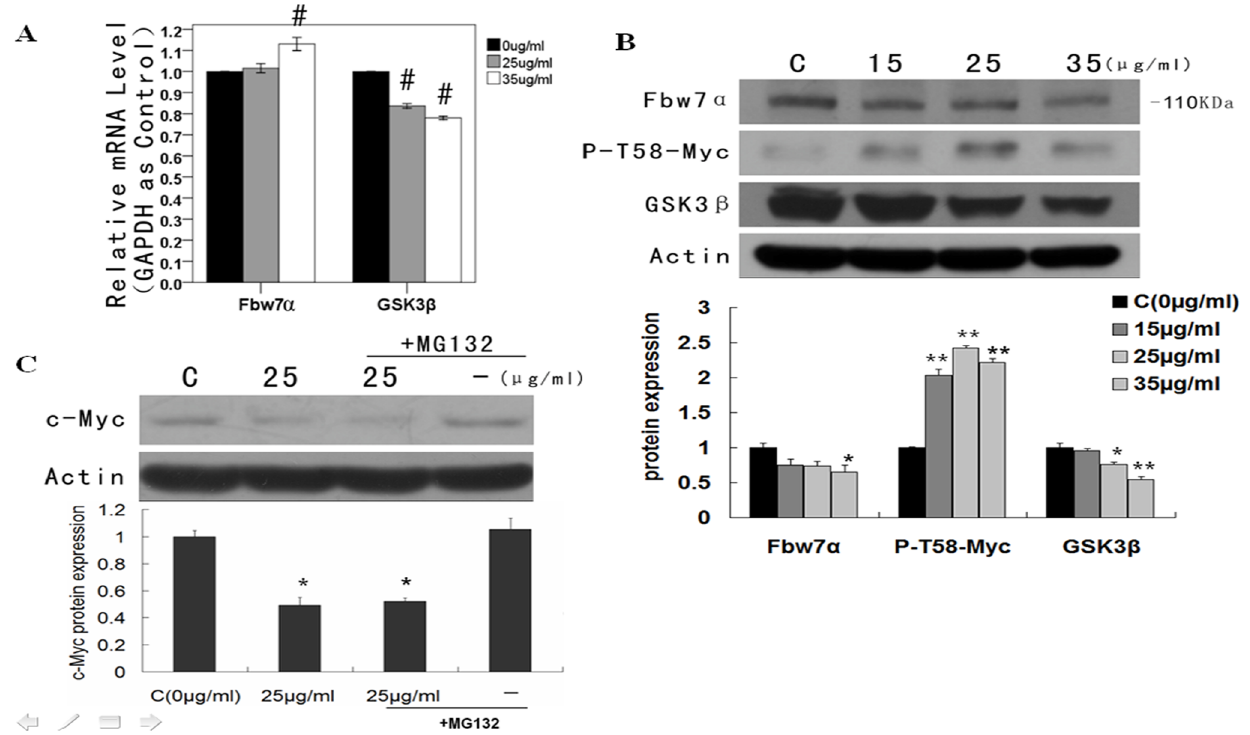
Figure 5. Effects of wogonin on Fbw7 a and GSK3 b in A549. (A) Relative mRNA levels of Fbw7 a and GSK3 b were detected using real-time PCR with GAPDH as an internal control. Results are expressed as the mean 6 SEM of five independent experiments. # P , 0.01 vs control group. (B) Protein levels of Fbw7 a , Thr58-Myc and GSK3 b assayed by western blot. (C) Protein levels of c-Myc assayed by western blot. In these experiments, 1 m M MG132 was added incubated with or without 25 m g/mL wogonin for 48 h. * P , 0.05 vs control group, ** P , 0.01 vs control group.